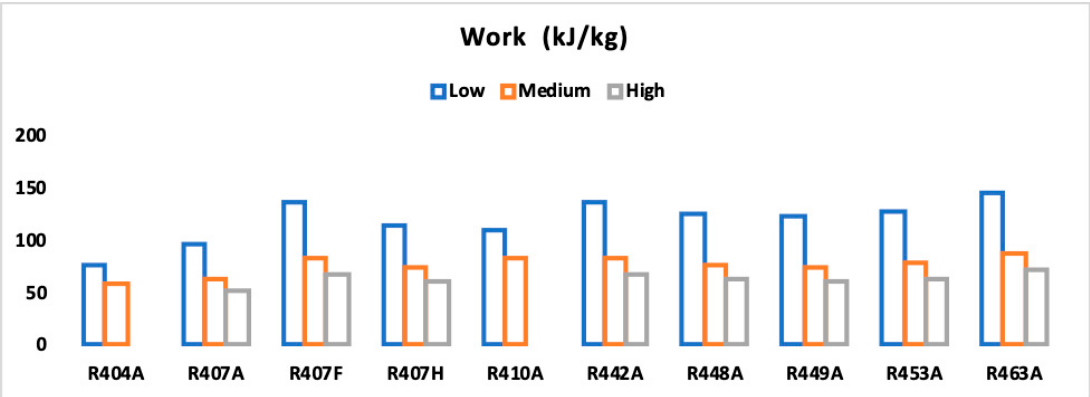
Figure 14. Refrigerant work of all refrigerants.